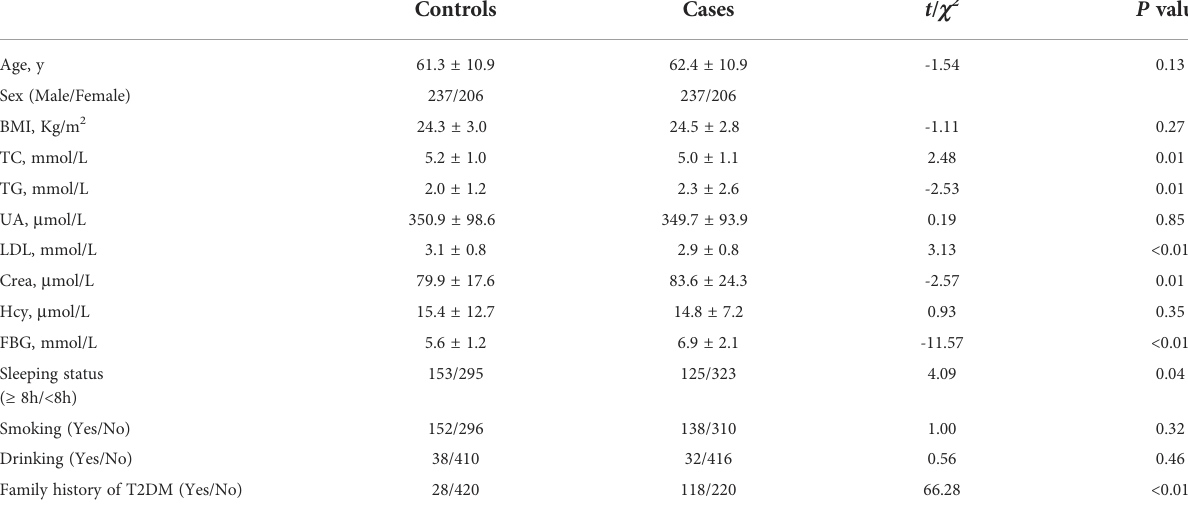
TABLE 1 The baseline characteristics of cases (T2DM and hypertension) and controls (hypertension).